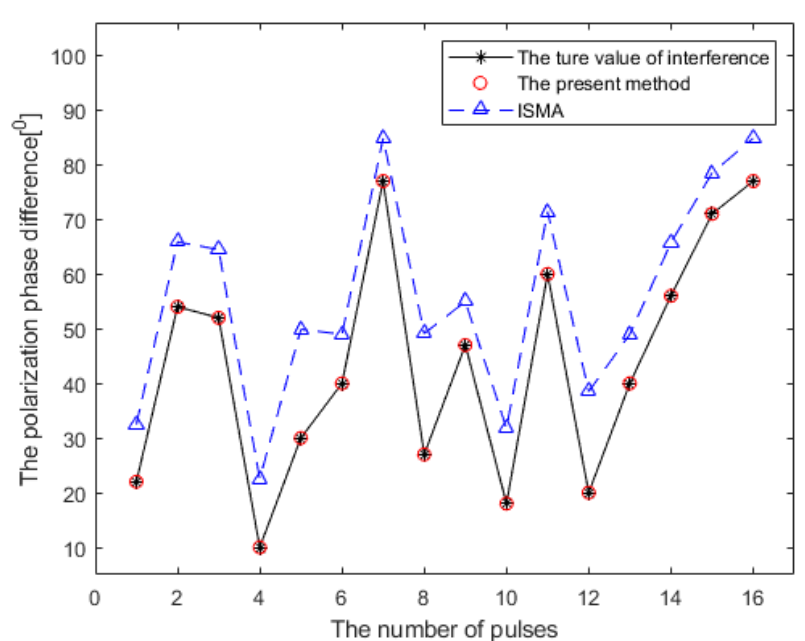
Figure 12. The estimation of the two methods under ISR 1 = 28 dB.